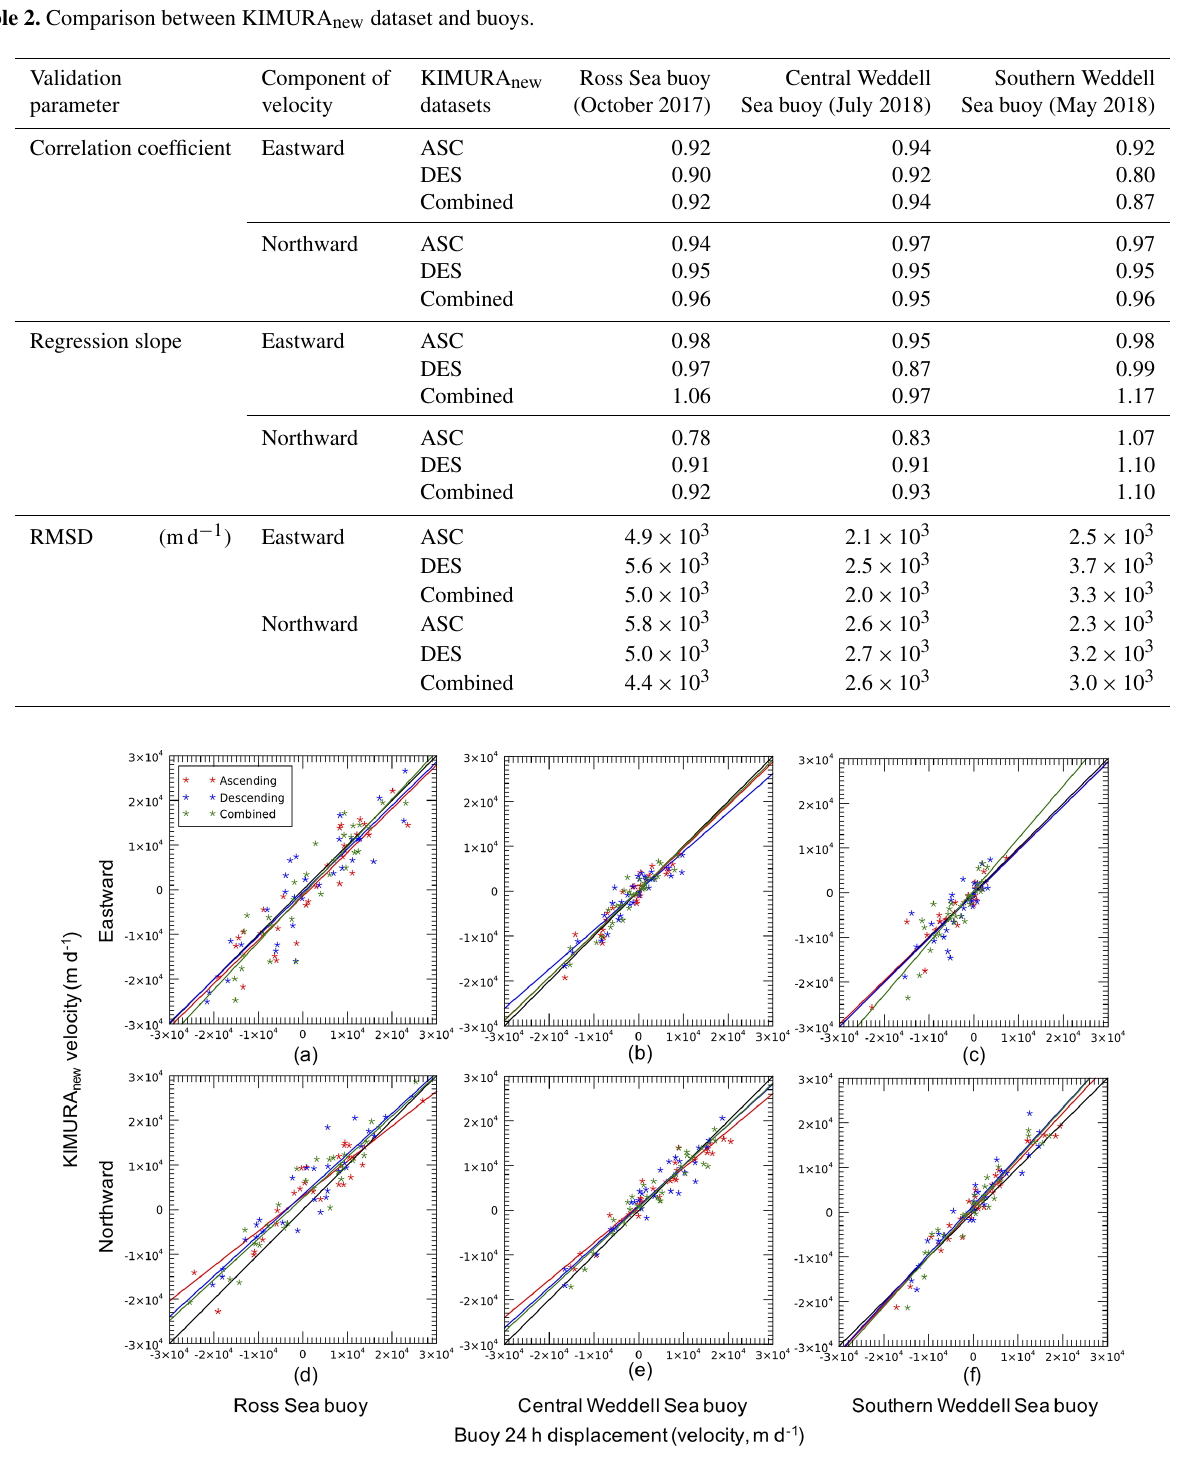
The Cryosphere, 16, 1299–1314,